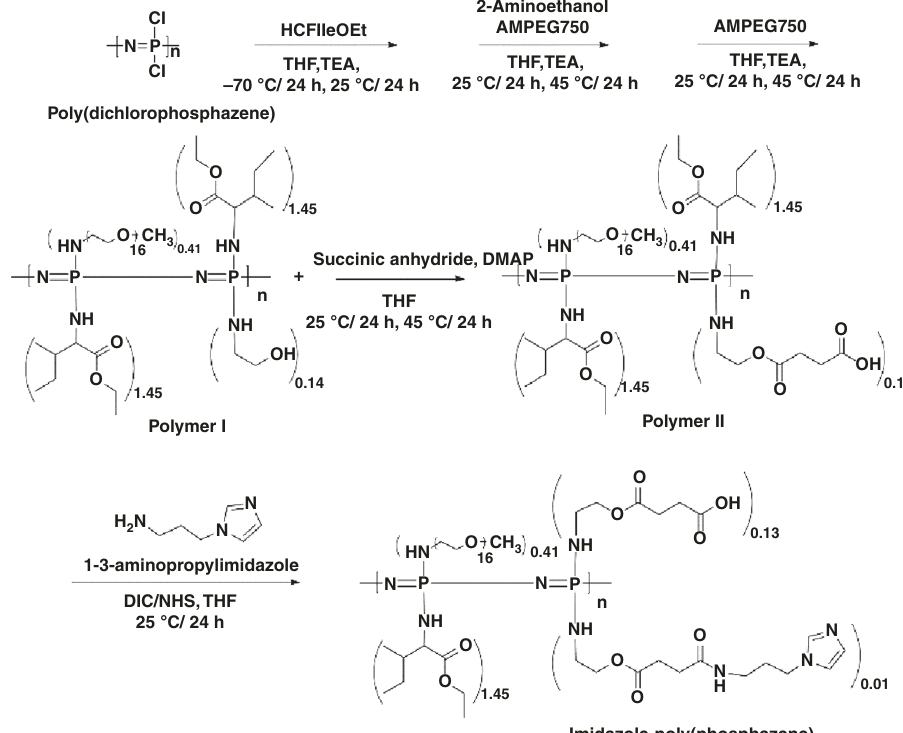
Fig. 1 Schematic of the synthesis of I-5. AMPEG , α -amino- ω -methoxy-poly(ethylene glycol); DMAP , 4-(dimethylamino)pyridine; DIC , diisopropylcarbodiimide; IleOEt , isoleucin ethyl ester; NHS, N- hydroxysuccinimide; THF , tetrahydrofuran; TEA , trimethylamine NATURE COMMUNICATIONS | 8: 533 | DOI: 10.1038/s41467-017-00583-8 |